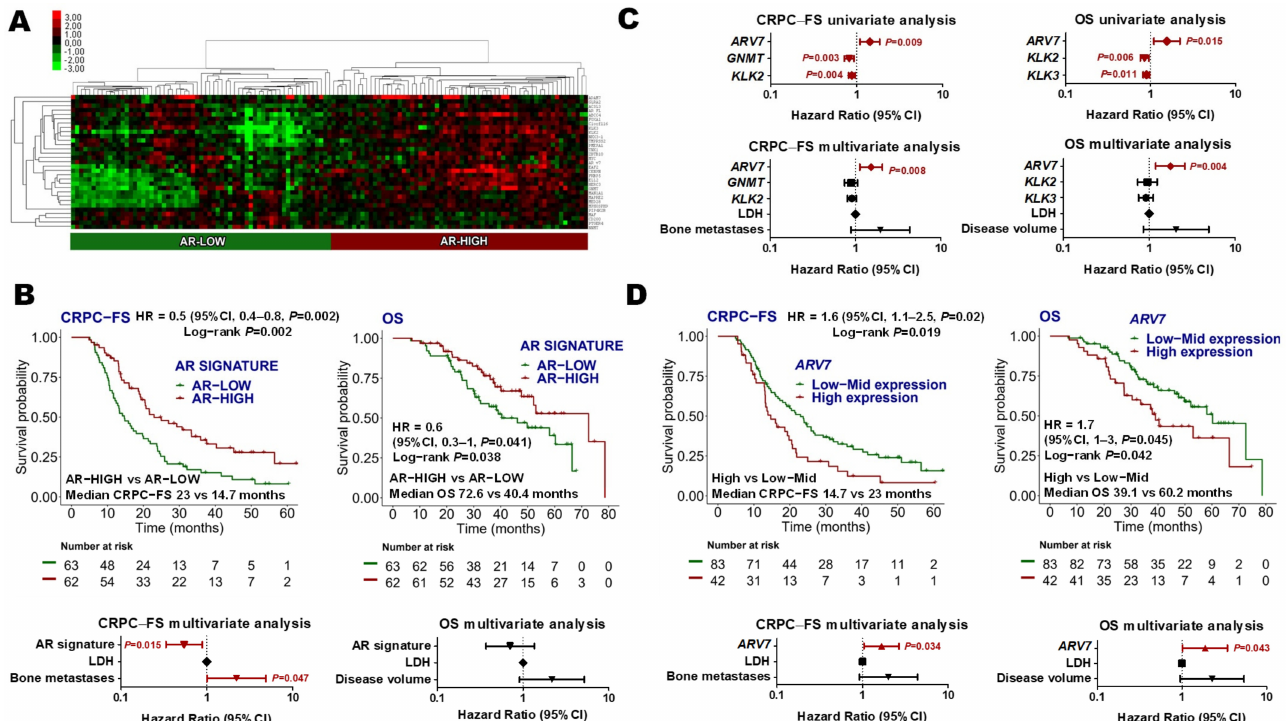
Figure 2. Androgen receptor (AR) signature. ( A ) Hierarchical clustering expression heatmap for expression values of the AR signature; ( B ) Kaplan–Meier curves representing CRPC-free survival (CRPC-FS) and overall survival (OS) according to AR signature and forest plots representing the multivariate analysis; ( C ) forest plots representing the univariate and multivariate analysis of the individual genes of the AR signature as continuous variables for CRPC-FS and OS. An FDR < 0.2 was applied (only genes that accomplished this condition are represented in the univariate forest plot); ( D ) Kaplan–Meier curves representing CRPC-FS and OS according to ARV7 expression segregated into tertiles and forest plots representing the multivariate analysis. LDH: lactate dehydrogenase; HR: hazard ratio; CI, confidence